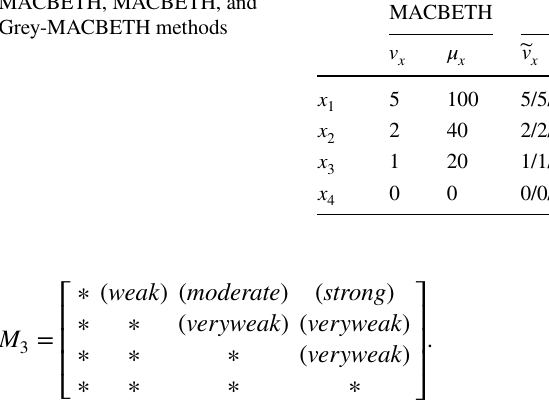
Classic Fuzzy-MACBETH MACBETH